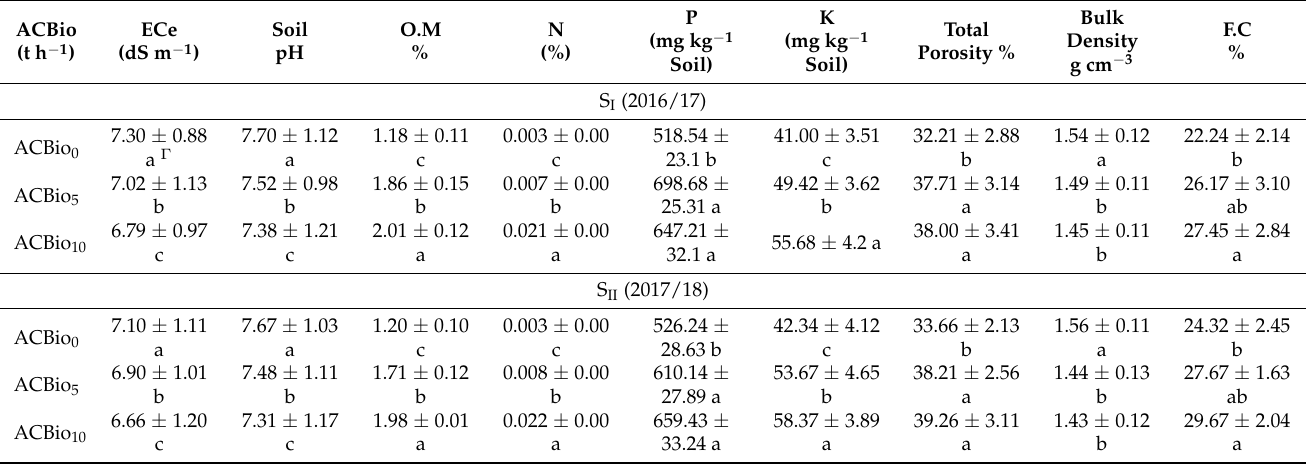
Table 3. Effect of acidified biochar rates on some physical and chemical properties at harvesting stage for S I (2016/17) and S II (2017/18)